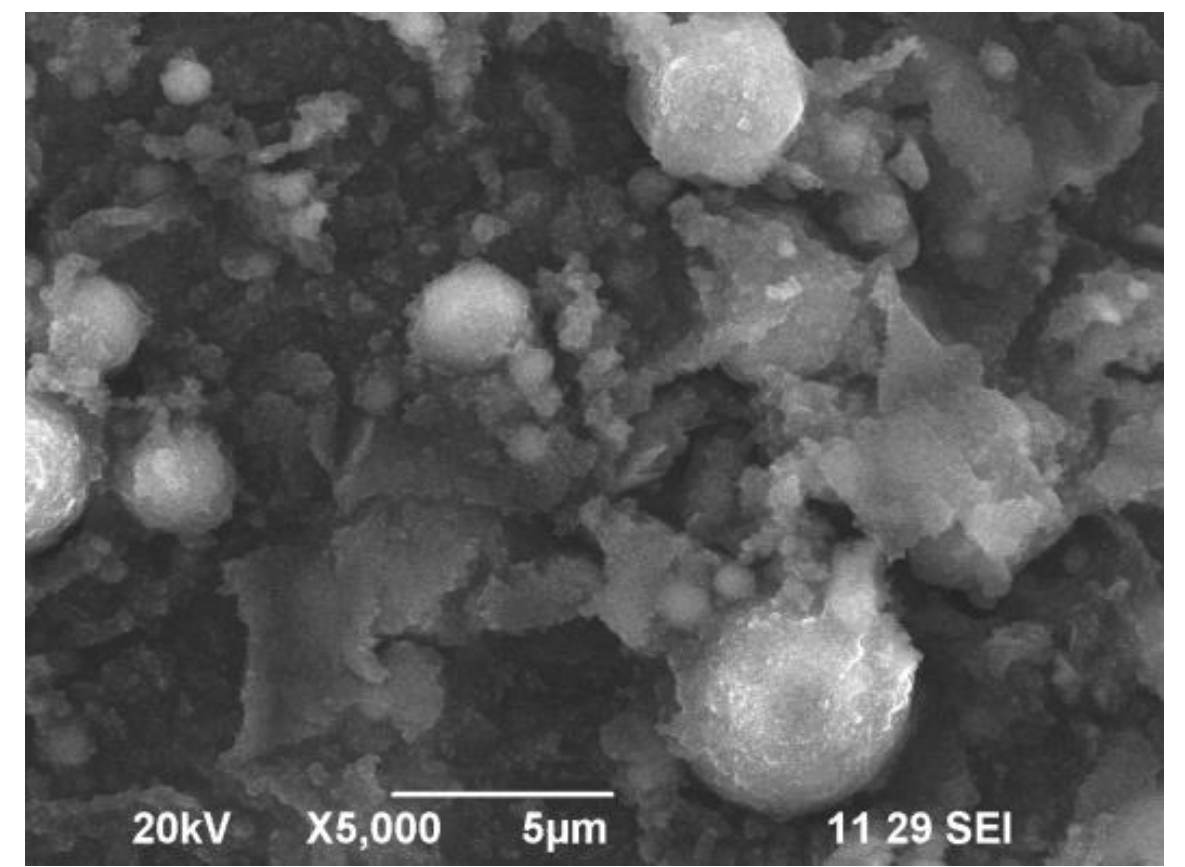
Figure 1. SEM image of the NiTi powder employed for FSP. Table 1. Mechanical properties of the commercially pure Mg plates used for